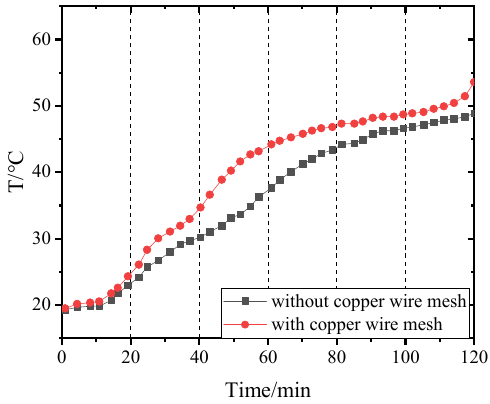
Figure 21. Temperature of point 4 in PCM-2 changing with time.